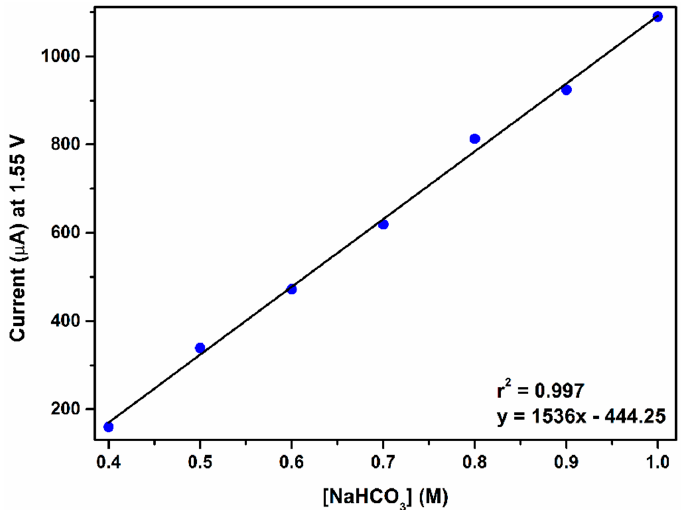
Figure 11. A plot of the catalytic peak/plateau current at 1.55 V vs. [NaHCO 3 ]. The voltammo- grams are recorded in 1.0 mM Na 3 [Ru 2 ( µ- CO 3 ) 4 ] with increasing concentrations of NaHCO 3 (pH 8.3) at a scan rate of 50 mV·s − 1